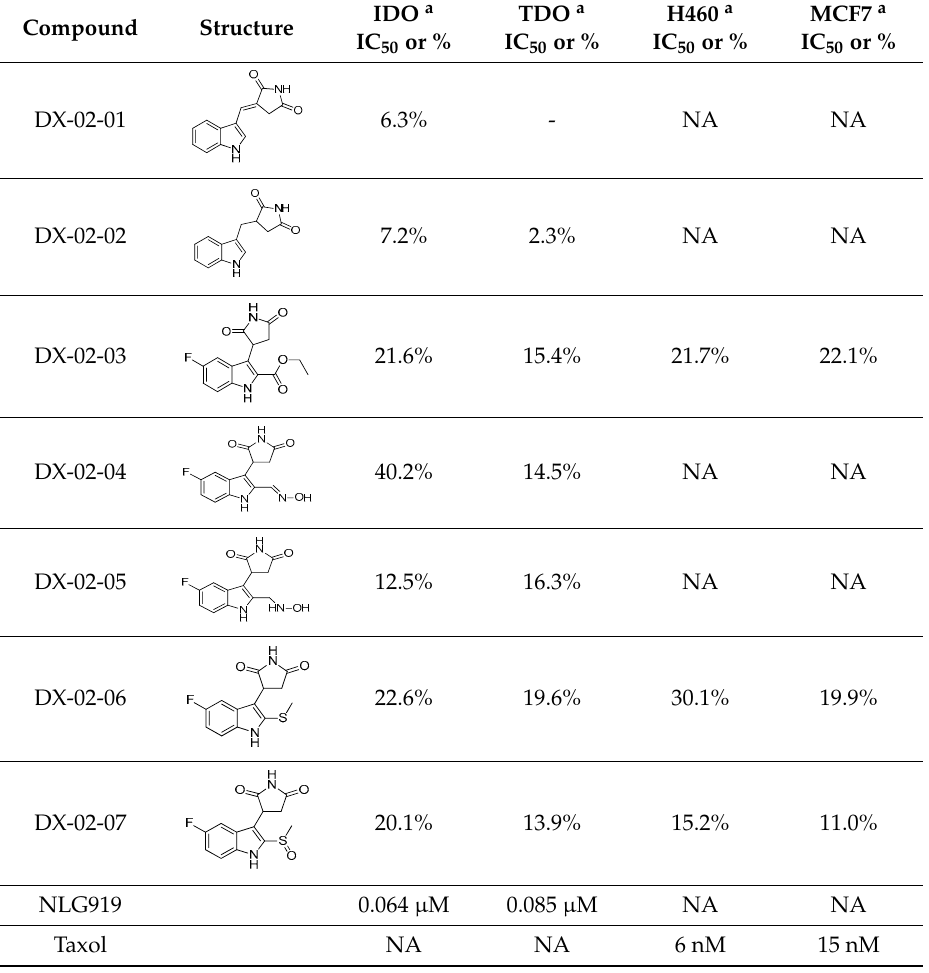
Table 2. In vitro IDO1 / TDO inhibitory activities and cell cytotoxicities of series 2. Table 2. In vitro IDO1/TDO inhibitory activities and cell cytotoxicities of series 2. Table 2. In vitro IDO1/TDO inhibitory activities and cell cytotoxicities of series 2. Table 2. In vitro IDO1/TDO inhibitory activities and cell cytotoxicities of series 2. Compound Table 2. In vitro IDO1/TDO inhibitory activities and cell cytotoxicities of series 2. Compound Table 2. In vitro IDO1/TDO inhibitory activities and cell cytotoxicities of series 2. Compound Table 2. In vitro IDO1/TDO inhibitory activities and cell cytotoxicities of series 2. Compound Compound Compound Compound